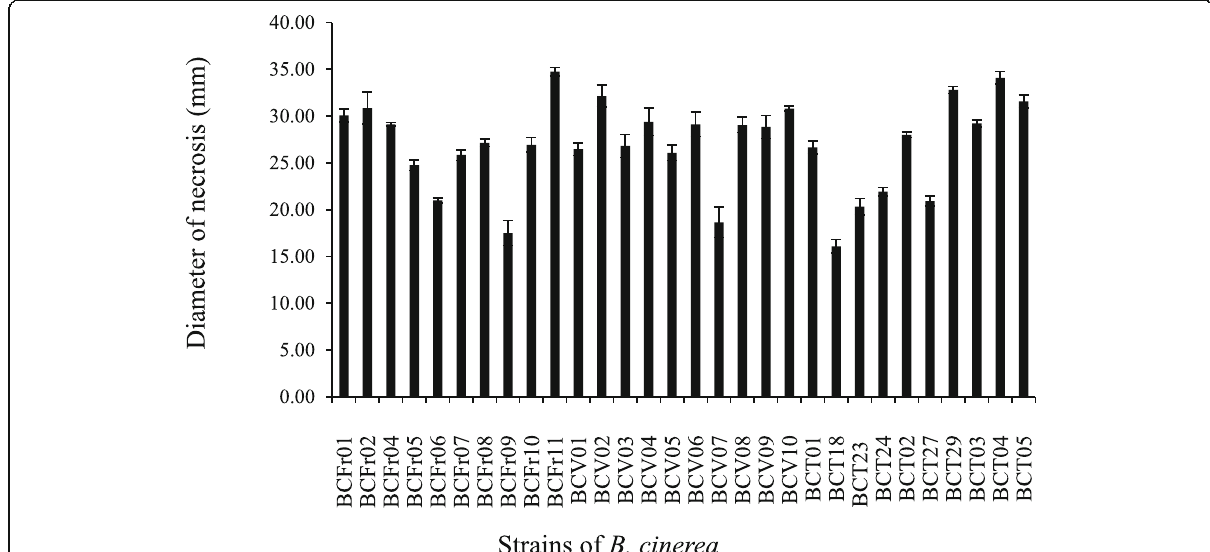
Fig. 1 Pathogenicity test of B. cinerea isolates on half apples of the variety Golden Delicious, after incubation for 3 days at 21 °C. The values are the mean of the technical and biological replicates